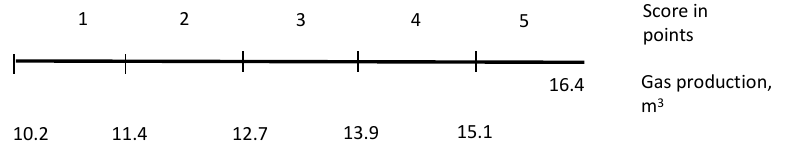
Figure 3. Base scale calculation scheme (source: designed by authors). B is the dimensional (true) value of the criterion (in our case, this is the value of gas production volumes); X is the desired (dimensionless—in points) value of the criterion in the base scale. From the proportion of the ratio of segments in Figure 3, we have: 𝑋 − 𝑚𝑖𝑛 (cid:2869) = 𝐵 − 𝑚𝑖𝑛 (cid:2870) ∆ (cid:2870)